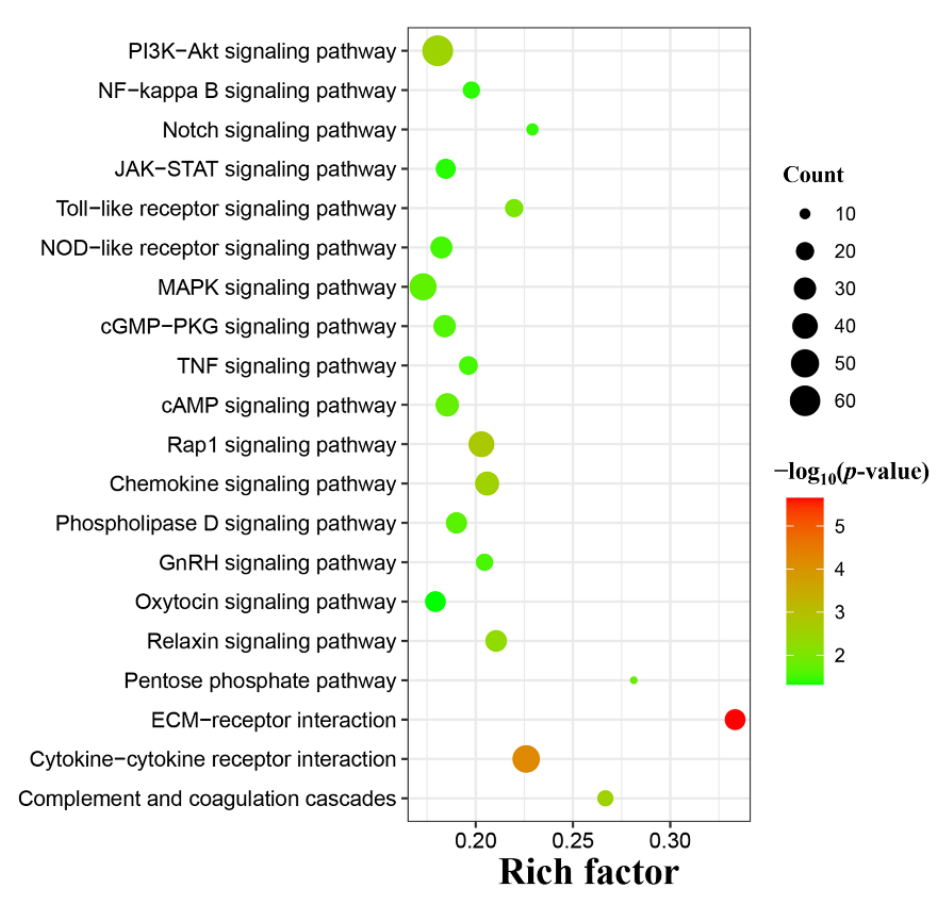
Figure 4. Classical signaling pathways were identified in this study. The X-axis label represents the rich factor, and the Y-axis label shows the KEGG pathways. The rich factor reflects the proportion of differentially expressed mRNAs (DEmRNAs) in a given pathway. The greater the rich factor, the greater the degree of pathway enrichment. The color of the dots represents the enrichment score [ − log 10 ( p -value)], where red indicates high enrichment and green indicates low enrichment. Dot size represents the number of DEmRNAs in the corresponding pathway (bigger dots indicate larger DEmRNA numbers).